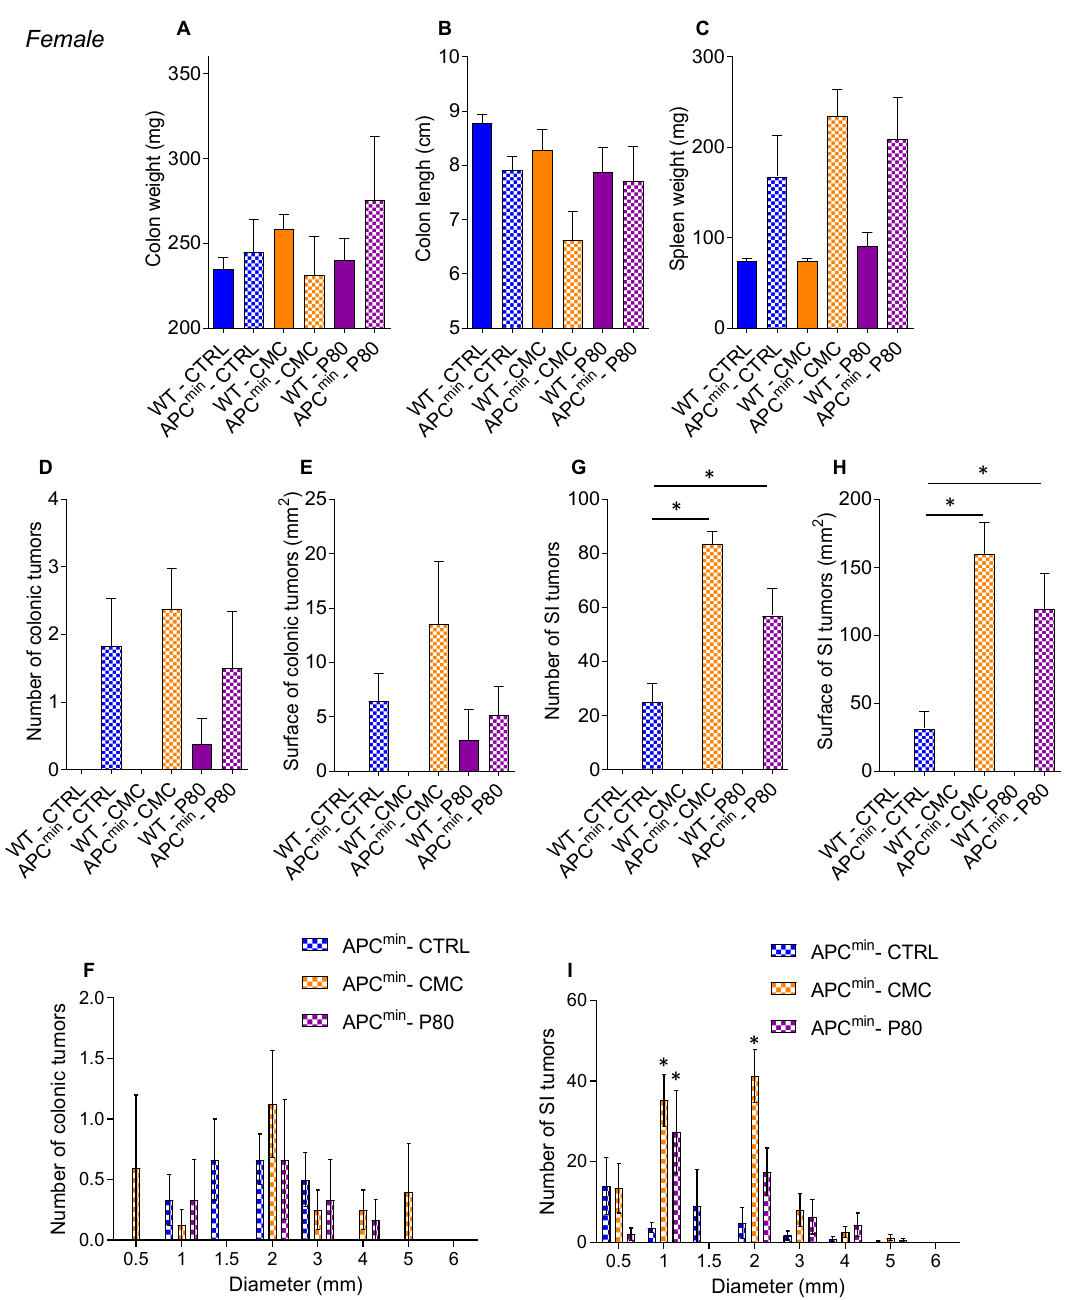
Figure 1. Dietary emulsifier consumption promotes intestinal tumors in adenomatous polyposis coli (APC) min female mice. Seven-week-old wild-type (WT) and APC min female mice were exposed to drinking water containing carboxymethylcellulose (CMC) or polysorbate 80 (P80) (1.0%) for 15 weeks. ( A ) Colon weights, ( B ) colon lengths, ( C ) spleen weights, ( D ) number of colonic tumors, ( E ) total colonic tumor surface determined with an ocular micrometer-fitted dissecting microscope, ( F ) number of colonic tumors based on their size, ( G ) number of small-intestine tumors, ( H ) total small-intestine tumor surface determined with an ocular micrometer-fitted dissecting microscope, ( I ) number of small-intestine tumors based on their size. Data are the means +/ − S.E.M. ( n = 13 for the WT–CTRL group, 6 for the APCmin–CTRL group, 8 for the WT–CMC group, 8 for the APC min –CMC group, 8 for the WT–P80 group and 5 for the APC min –P80 group). Significance was determined using one-way group ANOVA with a Bonferroni test (* indicates statistical significance).